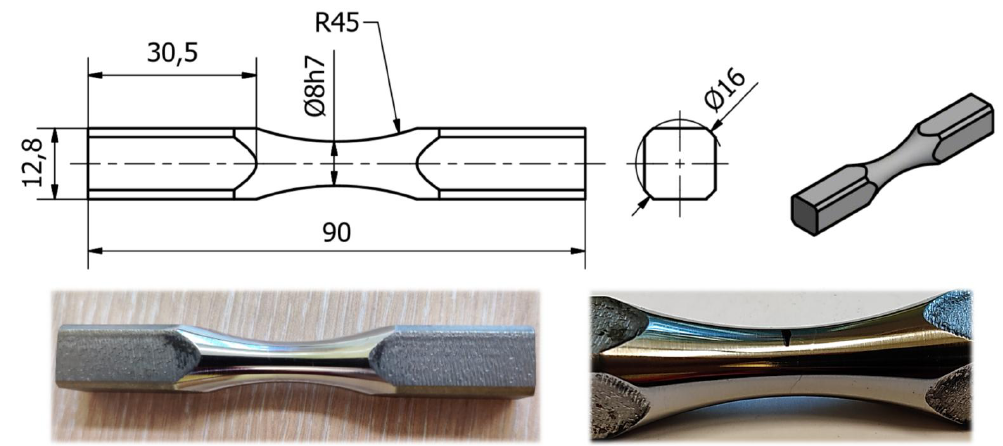
Figure 1. Test specimen. All dimensions are provided in